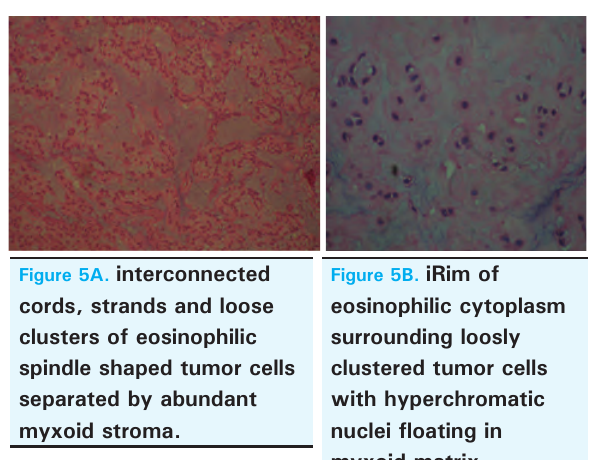
Figure 4. MRI Pictures of the lesion.